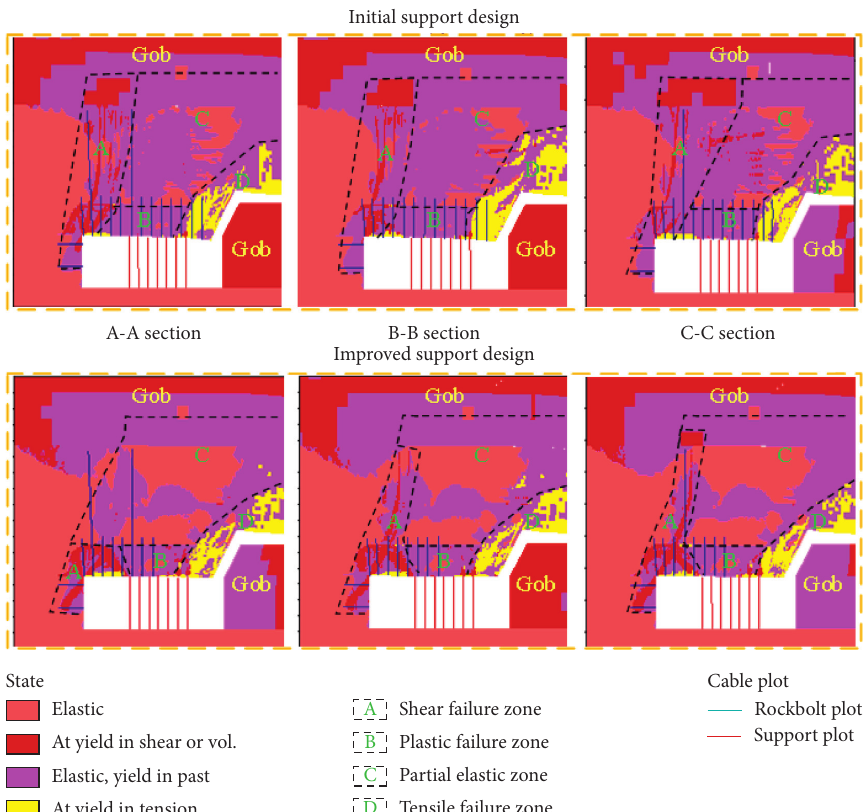
Figure 21: Plastic zone distributions of the two support